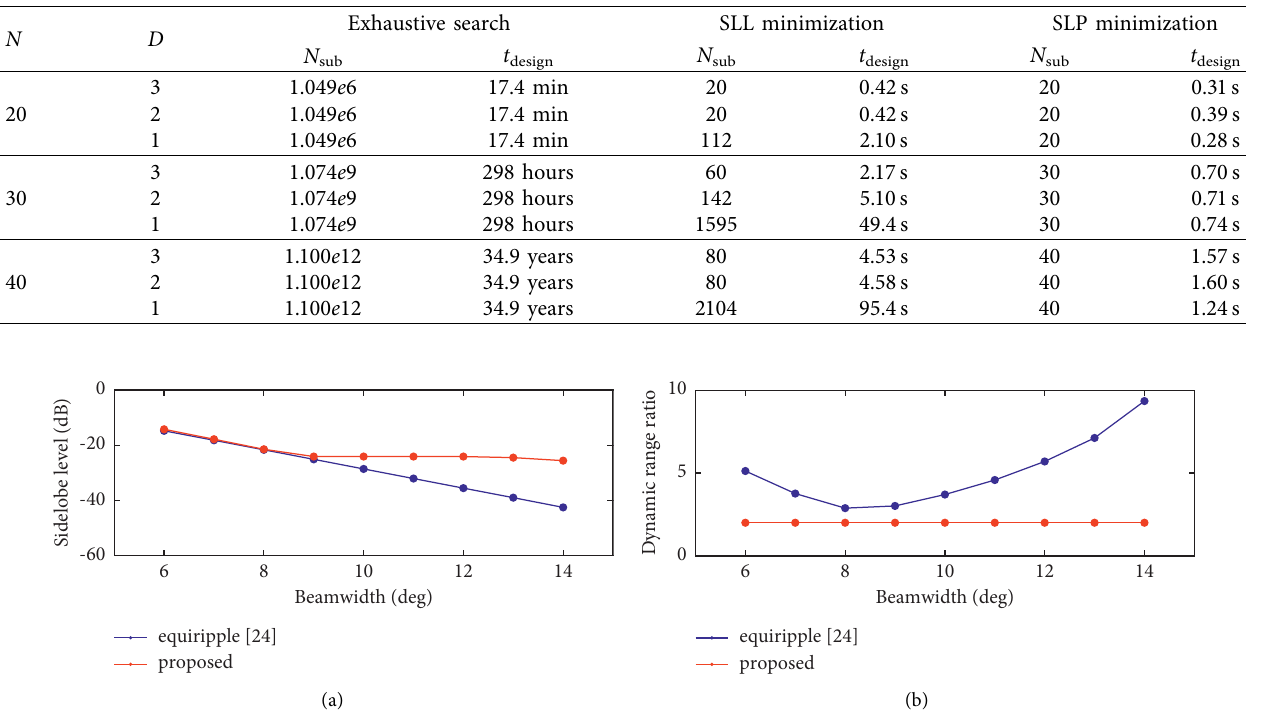
Figure 2: (a) Sidelobe level and (b) Dynamic range ratio of pencil beam arrays with 30 elements obtained by minimization of SLL and DRR constrained to D � 2, compared to DRR-unconstrained minimax design